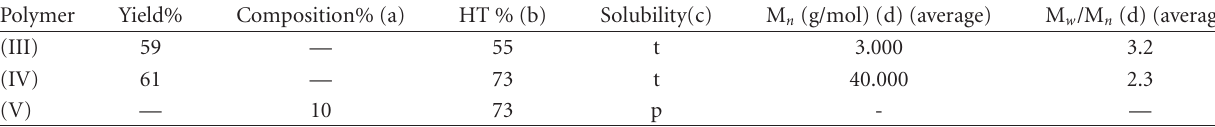
Figure 3: UV-Vis spectra in CHCl 3 for monomers (I), (II) and polymers (III), (IV). Table 2: Characterization of the polymers.